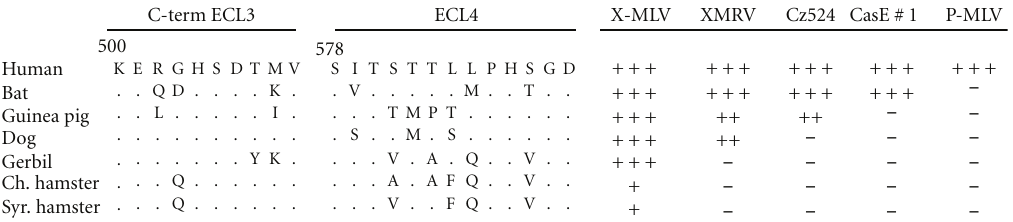
incorporation of this Env into virions in virus-infected cells results in their reduced infectivity